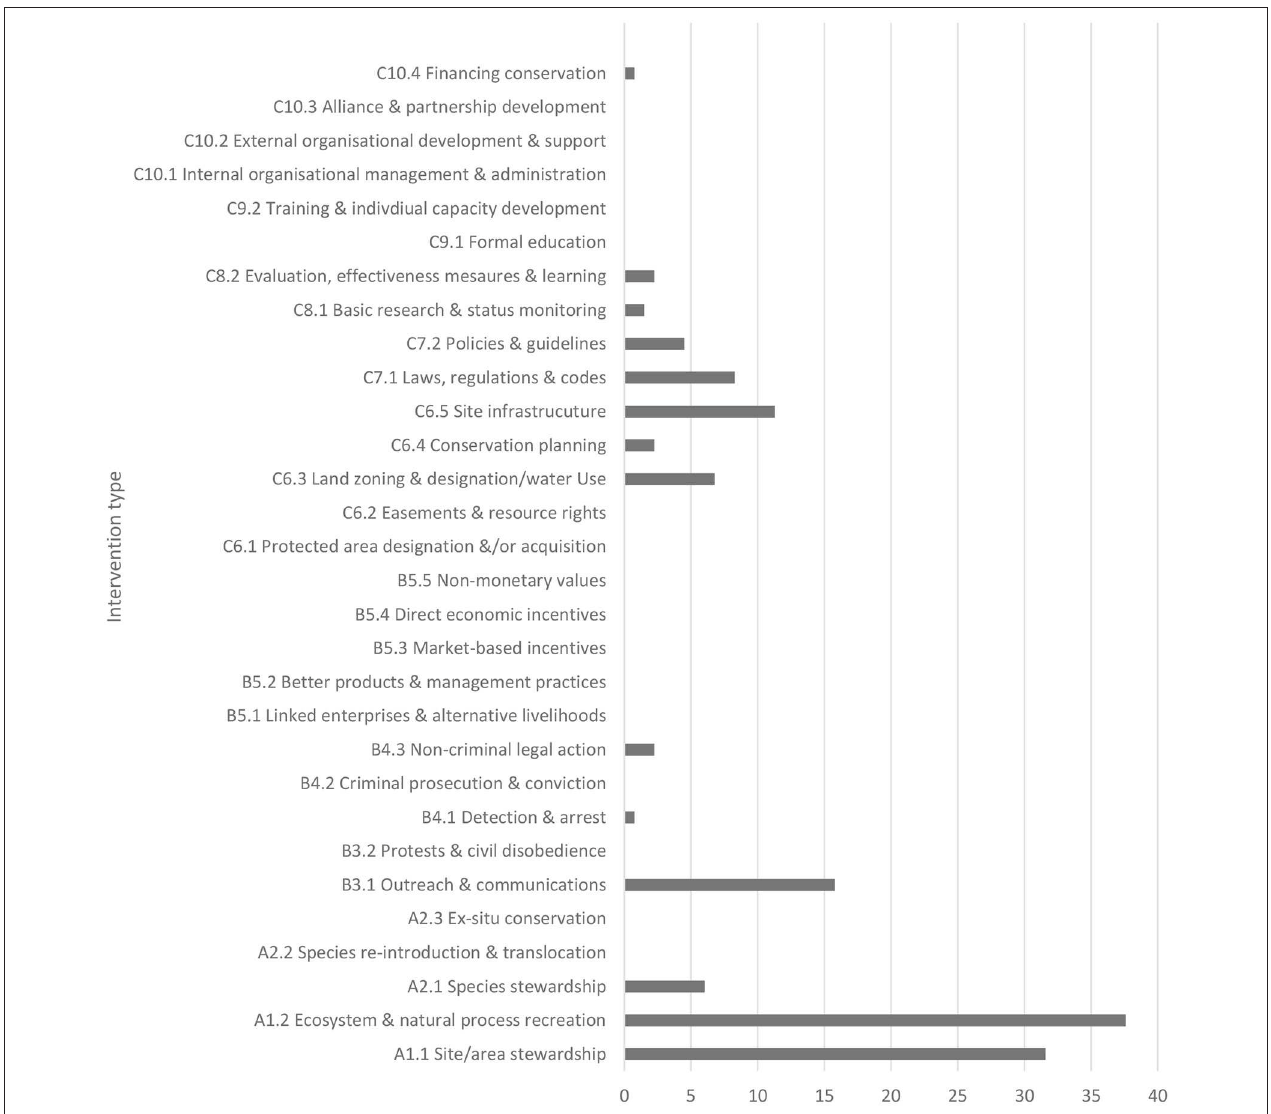
FIGURE 10 | The distribution of the 133 recommended interventions (from 64 publications) for Level 2 of CMP A (Target Restoration/Stress Reduction Actions), CMP B (Behavioural Change/Threat Reduction Actions), and CMP C (Enabling Condition Actions), classified according to the Conservation Measures Partnership (CMP; Conservation Actions Classification v 2.00 Framework Level 3; Supplementary Material 3 ). Note that a single publication can recommend several